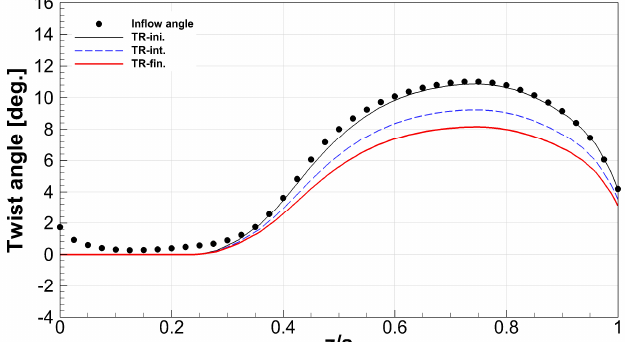
Figure 12. Distributions of twist angles along the span direction.